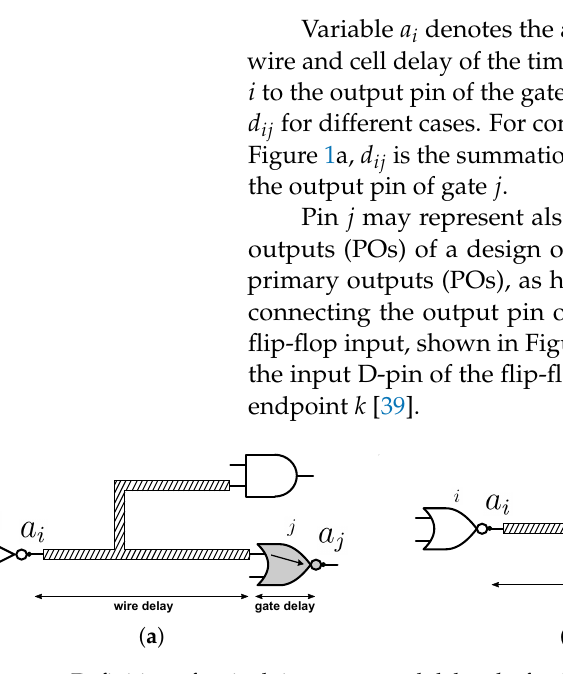
Figure 1. Definition of arrival times a i , a j and delay d i , j for ( a ) combinational gates, ( b ) primary outputs and ( c )